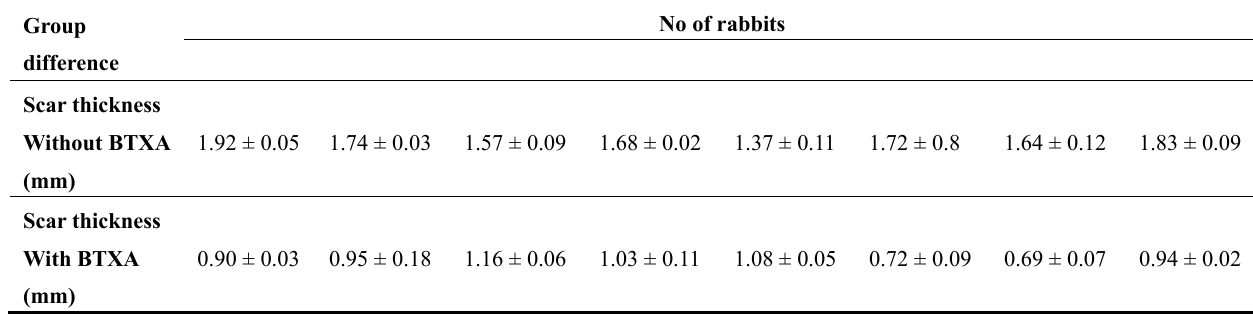
Table 1. Comparision of the thickness of two groups of hypertrophic